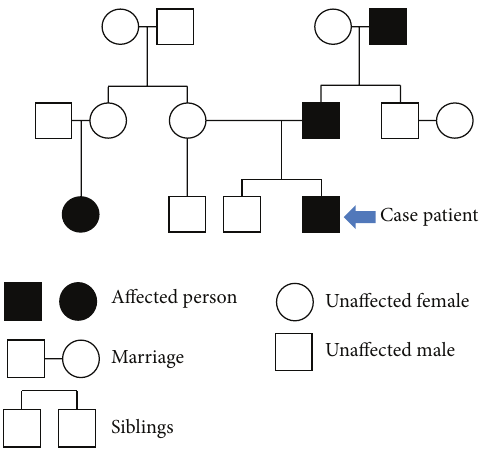
Figure 4: Family pedigree of individuals affected with PCC/PGL.